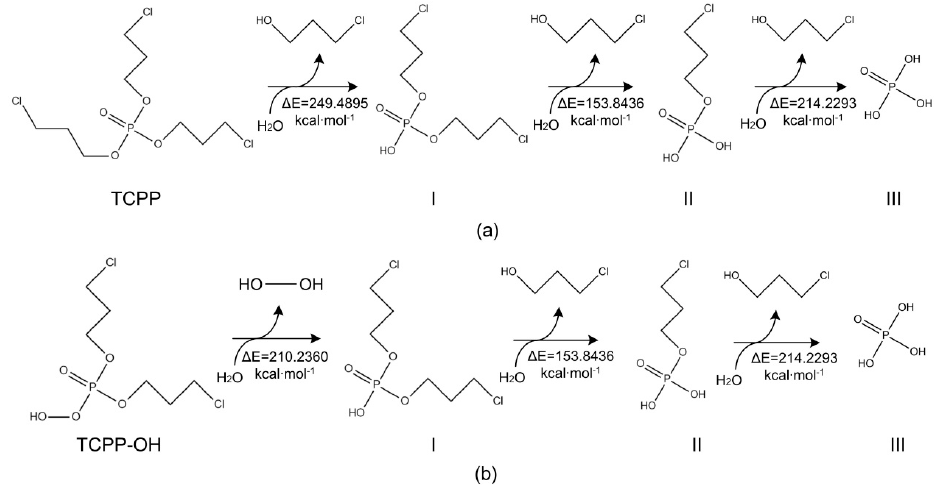
Figure 3. Proposed biodegradation pathway of TCPP before ( a ) and after modification ( b ).